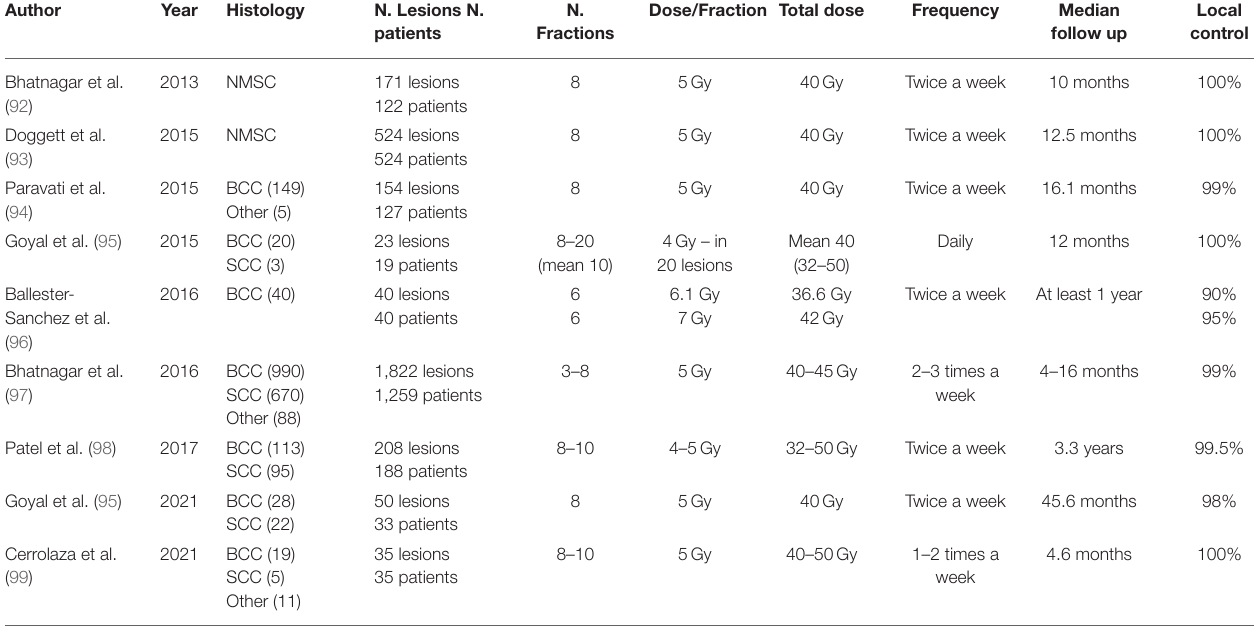
TABLE 3 | Surface applicators, electronic